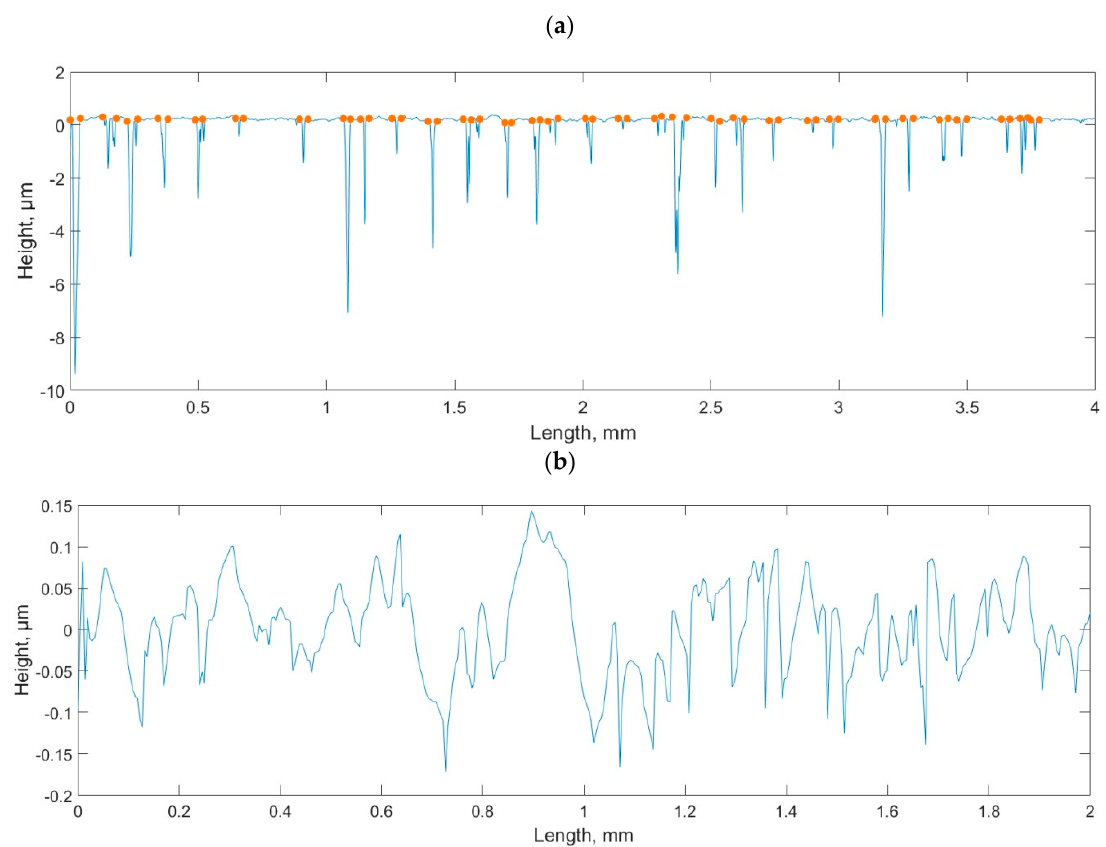
Figure 10. Profile with valley edges ( a ), connected plateau details ( b ), adapted from [87]. The probability parameters Rpq/Spq, Rvq/Svq, and Rmq/Smq can also be obtained from the height distribution